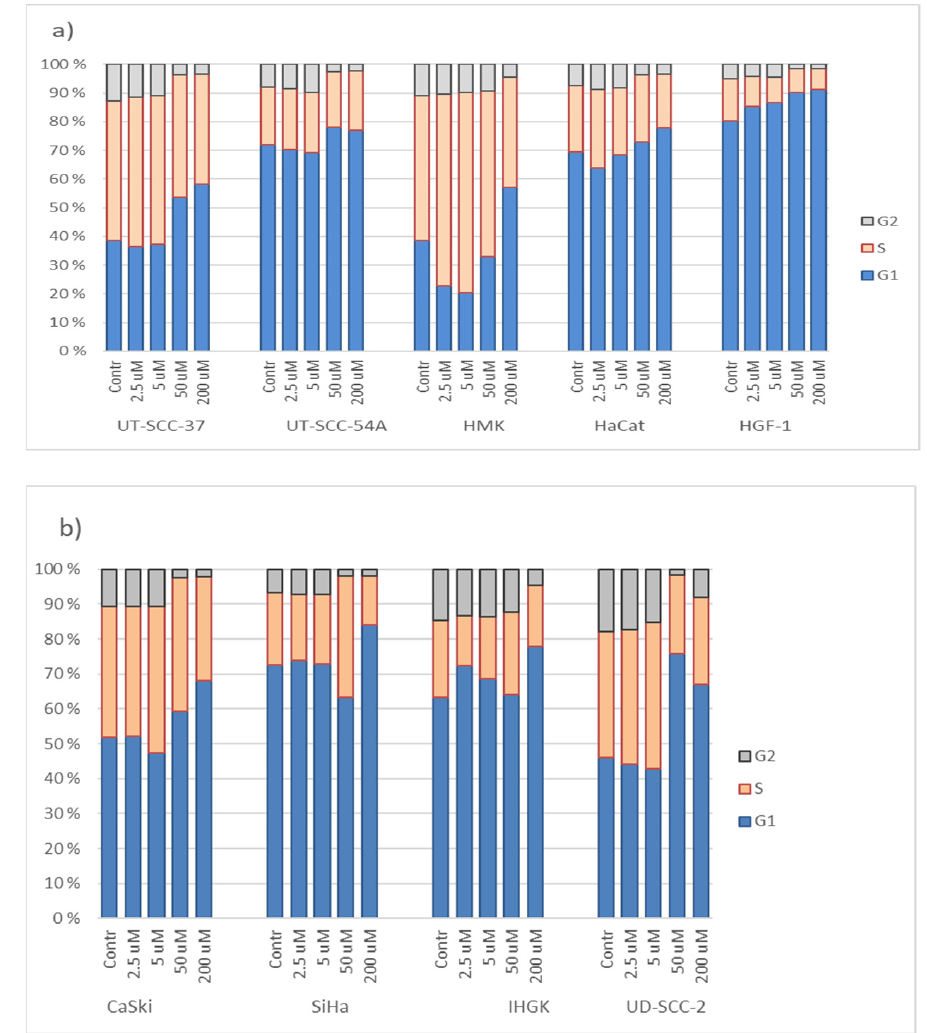
Figure 3. The effect of hinokitiol on the cell cycle of ( a ) HPV ‐ negative and ( b ) HPV ‐ positive cell lines. The cells were exposed to different hinokitiol concentrations (0, 2.5, 5, 50, and 200 μ M) for 24 h and stained with propidium iodide for cell cycle analysis by flow cytometry. The data represents percentages (mean of three independent experiments) of cells in each stage of the cell cycle.